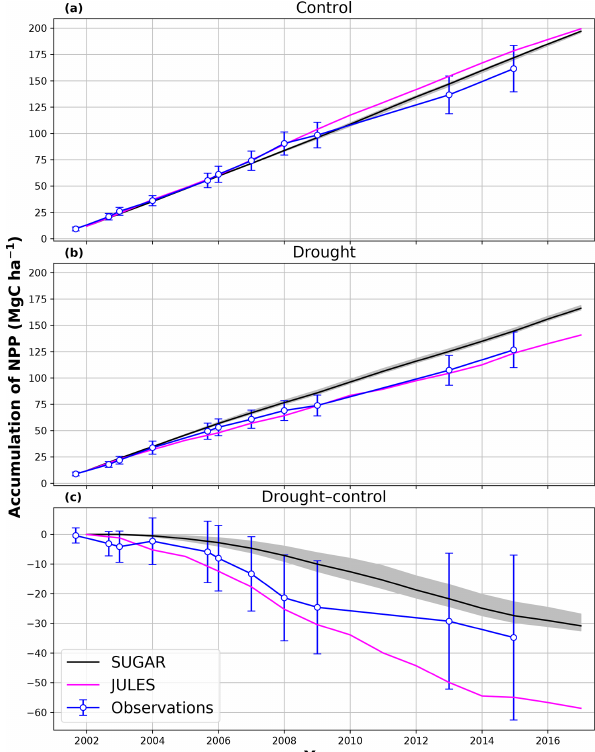
Figure A5. Accumulated net primary productivity at Caxiuanã in the (a) control plot and (b) TFE plot and (c) the difference between the drought and control forest (TFE–control). Soil moisture stress has been artificially reduced in JULES by 50%, and the resulting GPP has been used to drive SUGAR. Observations are calculated as the accumulated sum of biomass increment change and local litter fall (Rowland et al., 2018). The presented confidence intervals are the sum of the litter fall measurement error and the 95% confidence intervals of biomass increment calculated from eight allometric equations using trunk diameter at breast height (DBH) data from Caxiuanã.